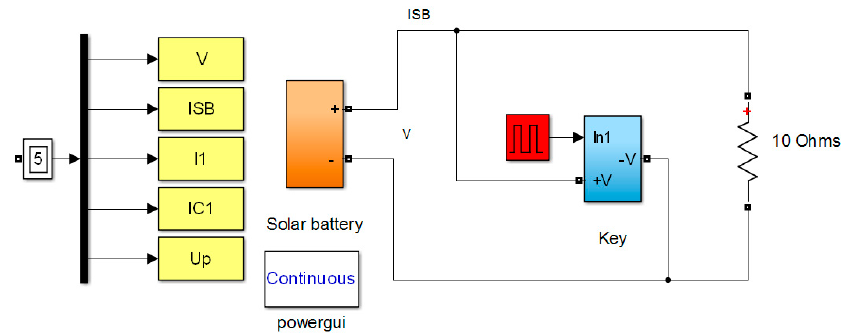
Figure A2. Simulation model for the study of transient processes in a solar panel.